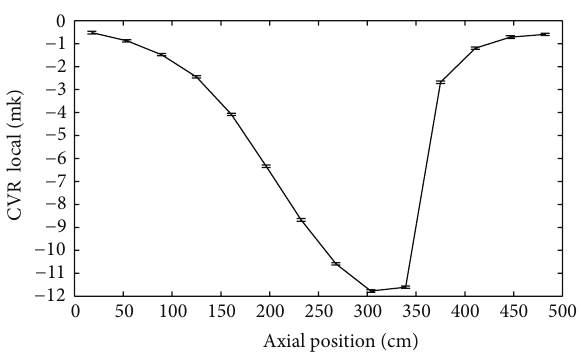
Figure 2: CVRs along a fuel channel obtained from independent 2D lattice cell calculations.